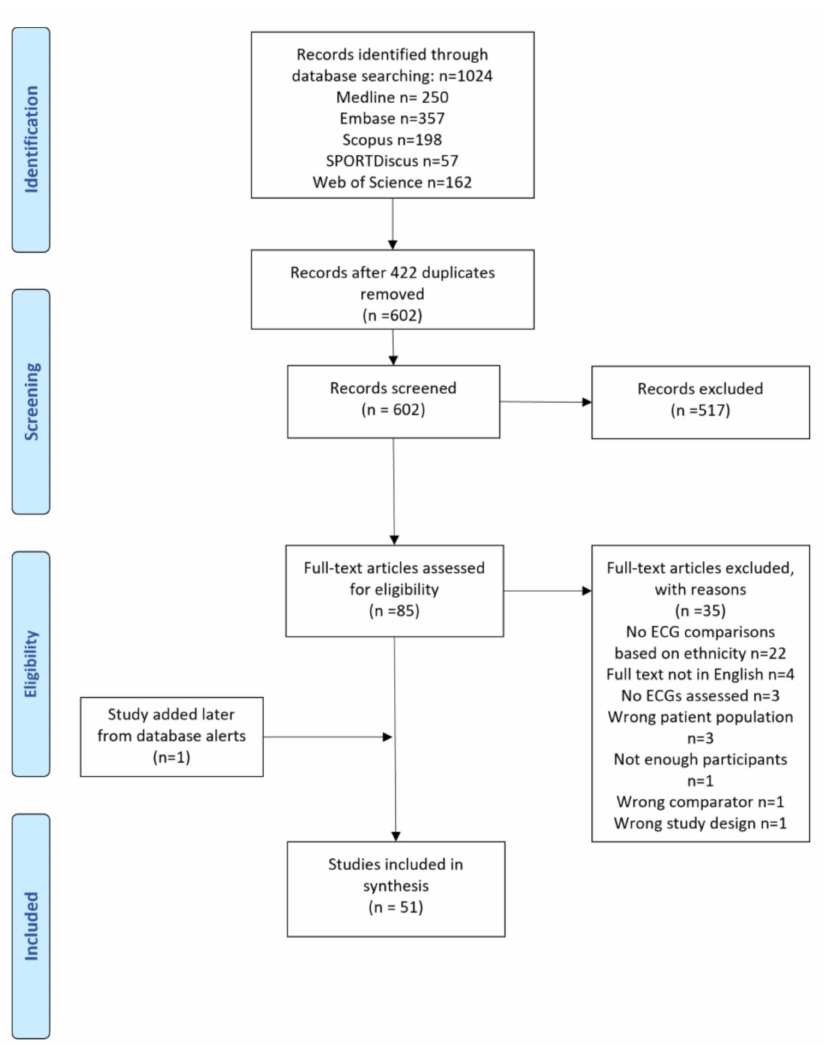
Figure 1. Flow diagram of included